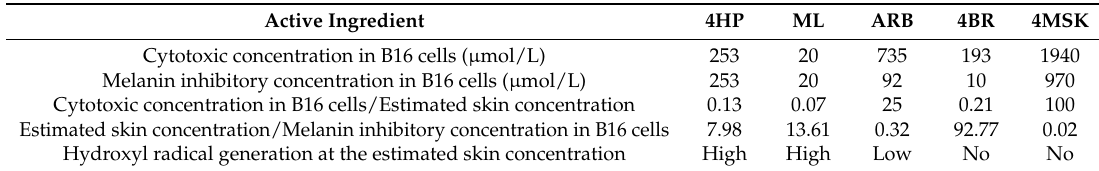
Table 3. In vitro B16 melanoma cytotoxicity concentration/estimated skin concentration and risk of hydroxyl radical generation.